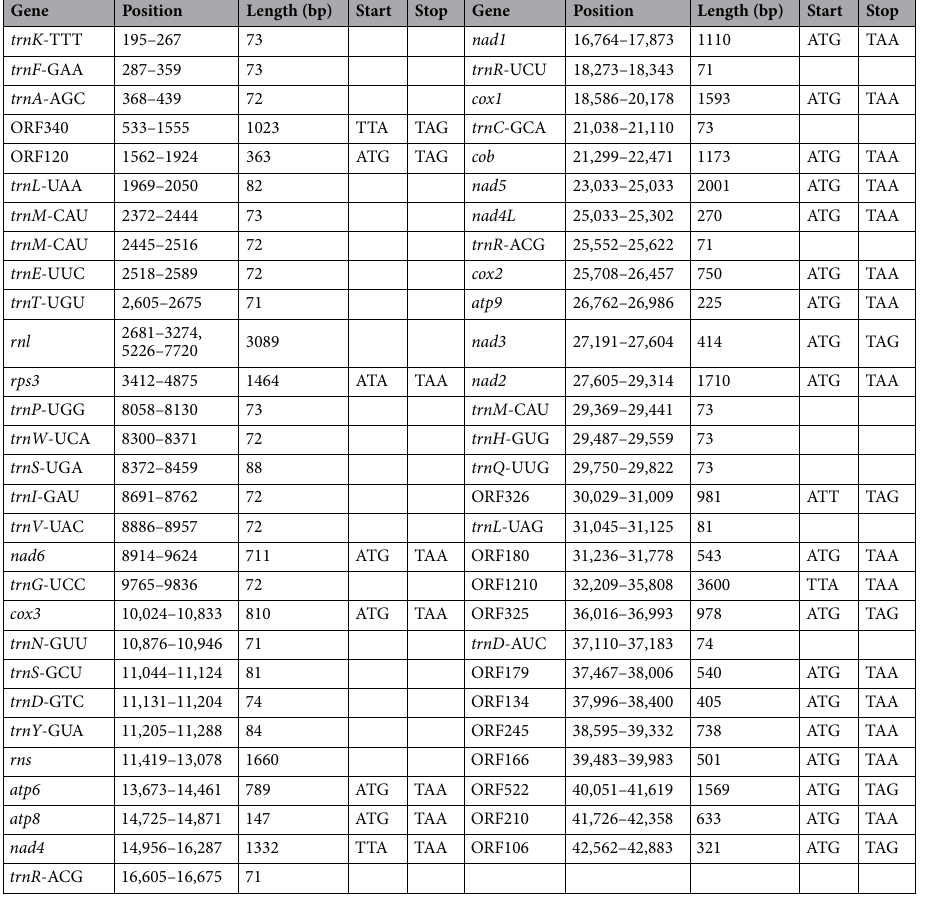
Table 1. List of annotated mitochondrial genes in Ilyonectria